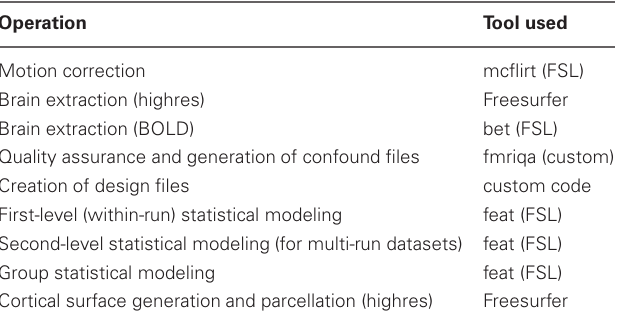
Table 1 | List of processing steps applied to data, and tools used for each